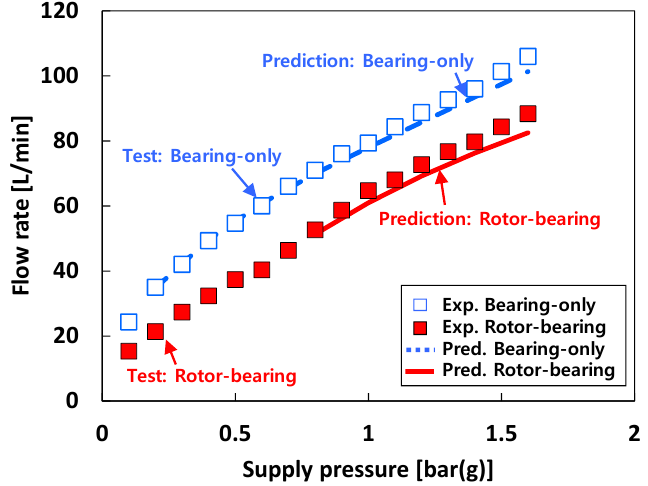
Figure 12. Predictions versus measurements. Test case #1: bearing flow rate of free end bearing. For test cases #2 and #3 (i.e., tests with water and liquid nitrogen, respectively), Figure 13a,b compare the predicted and measured flow rate of the free end bearing for the bear- ing-only (i.e., without rotor in the test bearings) and the rotor-bearing (i.e., rotor inserted in the test bearings) conditions, respectively. For the bearing-only condition, the water temperatures render nearly no effect on the bearing flow rates. Note that, for the bearing- only condition, the bearing flow rates for test case #3 (i.e., tests with liquid nitrogen) are quite similar to those for test case #2 (i.e., tests with water). On the other hand, for the rotor-bearing condition, the water temperature affects the bearing flow rate for test case #2. That is, the bearing flow rates increase with the water temperature. Predicted bearing flow rates for both the bearing-only and the rotor-bearing conditions are in good agree- ment with measurements.